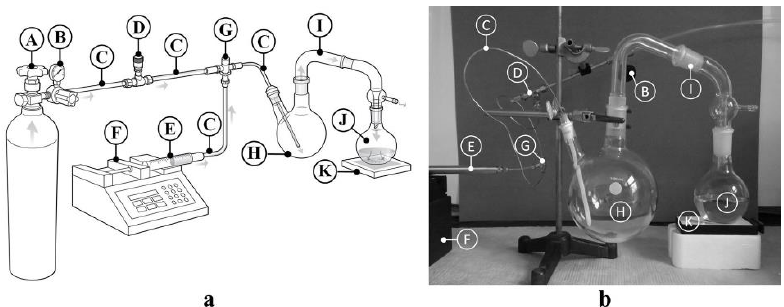
Figure 1. ( a ) Schematic ( b ) photograph of system configuration. A: Ultra-high purity (UHP) nitrogen 99.998%, B: single stage regulator set to 100 psi, C: 0.02” stainless-steel tubing, D: fine metering valve E: 2.5 mL stainless steel high pressure gastight syringe (with 25.1% w / v ammonia), F: syringe infusion pump, G: mixing tee (20 µ L), H: 1000 mL round bottom flask, I: vacuum distilling adapter, J: 250 mL flat bottom flask with 100 mL iron salt (Fe 2 +/ Fe 3 + ) solution, K: permanent neodymium magnet.